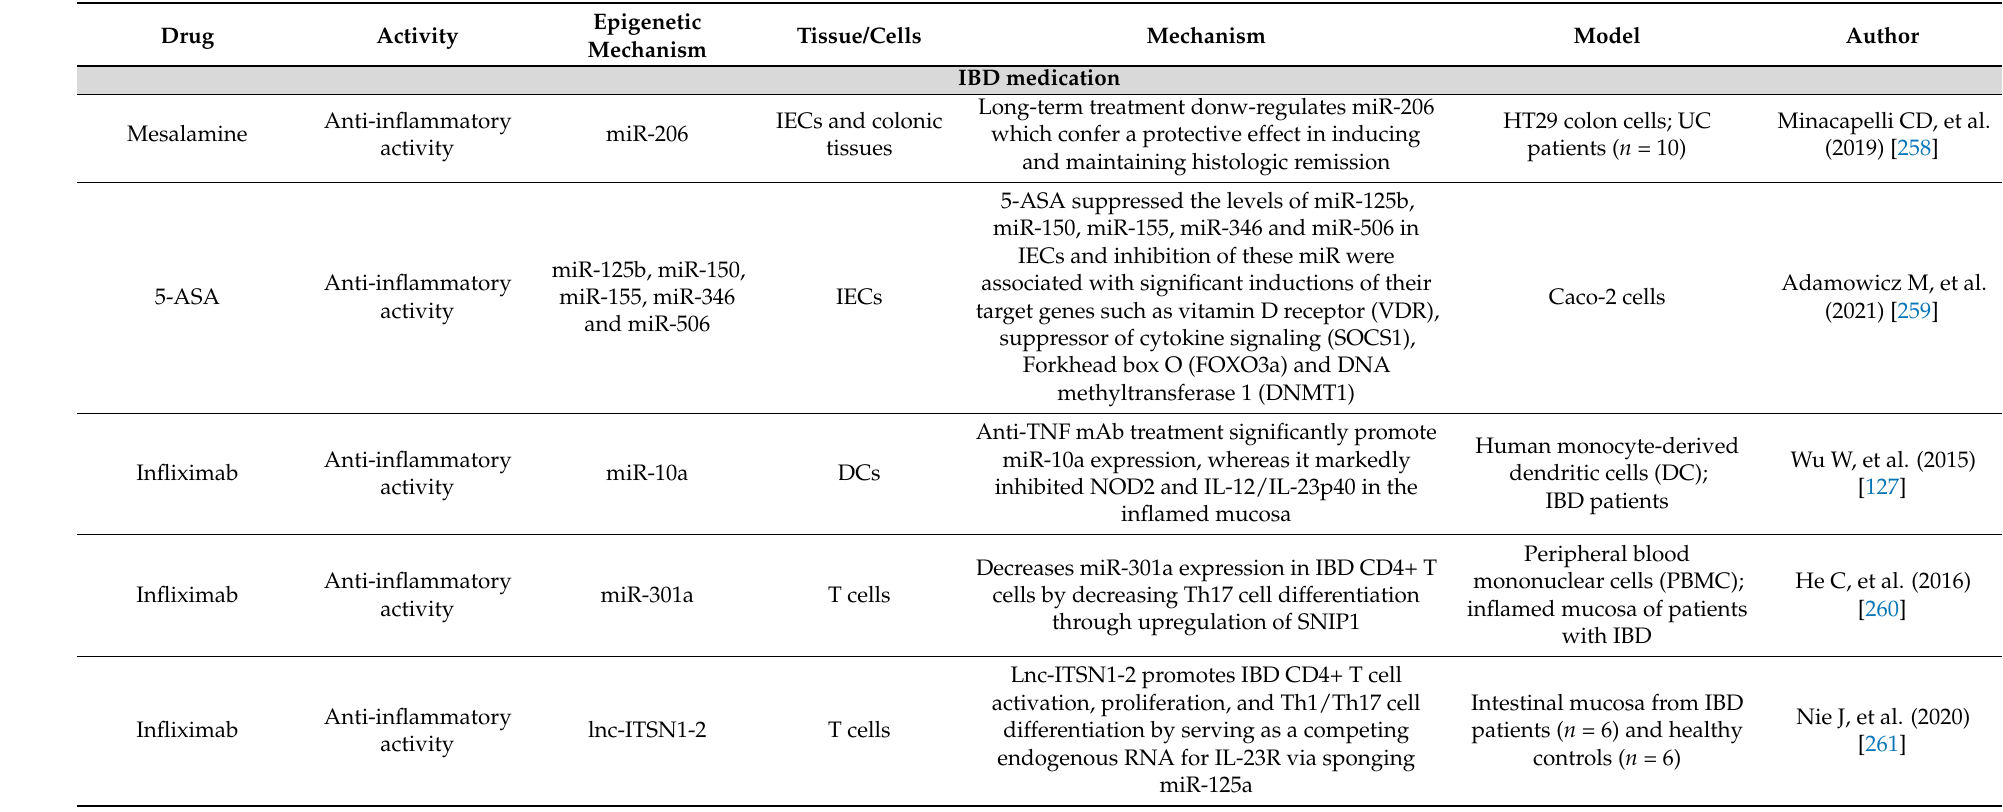
Table 4. Impact of drugs on epigenome in intestinal inflammation . 5-ASA, 5-aminosalicylic acid; CD, Crohn’s disease; circRNA, circular RNA; CpG, CpG, cytosine–phosphate–guanine; DNA, deoxyribonucleic acid; DNMT, DNA methyltransferase; DSS, dextran sulfate sodium; EEN, Exclusive enteral nutrition; EMT, epithelial-to-mesenchymal-transition; EV, extracellular vesicle; HDAC, histone deacetylases; HPM, Herb-partitioned moxibustion; IBD, inflammatory bowel disease; IEC, intestinal epithelial cell; IFN, interferon; IL, interleukin; lncRNA, long non-coding RNA; LPS, lipopolysaccharide; miR, micro-RNA; MSC, mesenchymal stem cell; PPAR- γ , peroxisome proliferator-activated receptor γ ; RNA, ribonucleic acid; SCFAs, short-chain fatty acids; SNIP1, Smad Nuclear Interacting Protein 1; STAT, signal transducer and activator of transcription; TLR, toll-like receptor; TNF, tumor necrosis factor; TNBS, 2,4,6-Trinitrobenzene sulfonic acid; UC, ulcerative colitis; VEGF, Vascular Endothelial Growth Factor; ZO, zonula